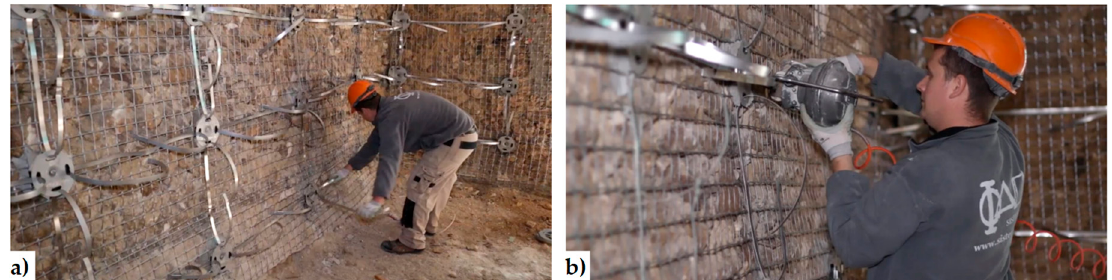
Figure 13. How to tie a masonry wall with the Φ system: ( a ) housing of the ribbons on the internal face of the wall; ( b ) clamping of ribbons [54].